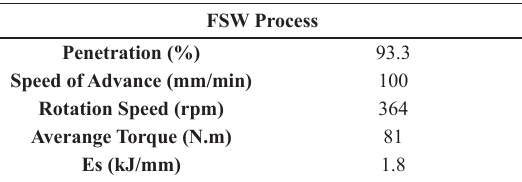
Table 2. Parameters used for welding and welding of medium energy.